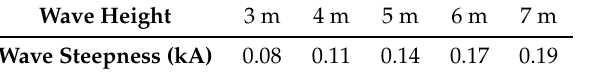
Table 2. Wave steepness.